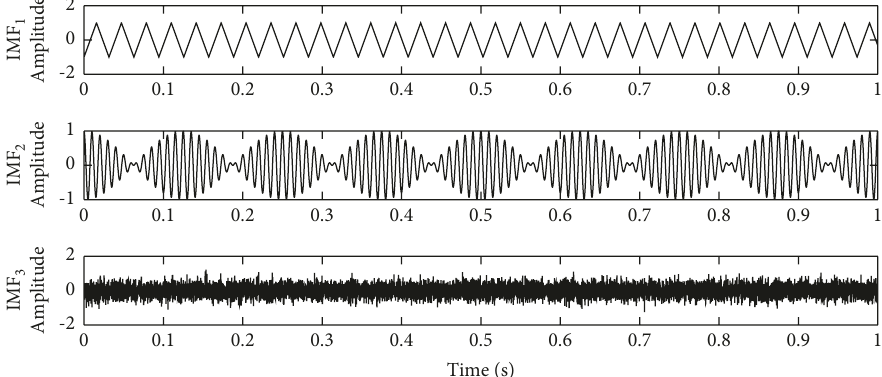
Figure 3: The decomposition result of x ( t ) generated by